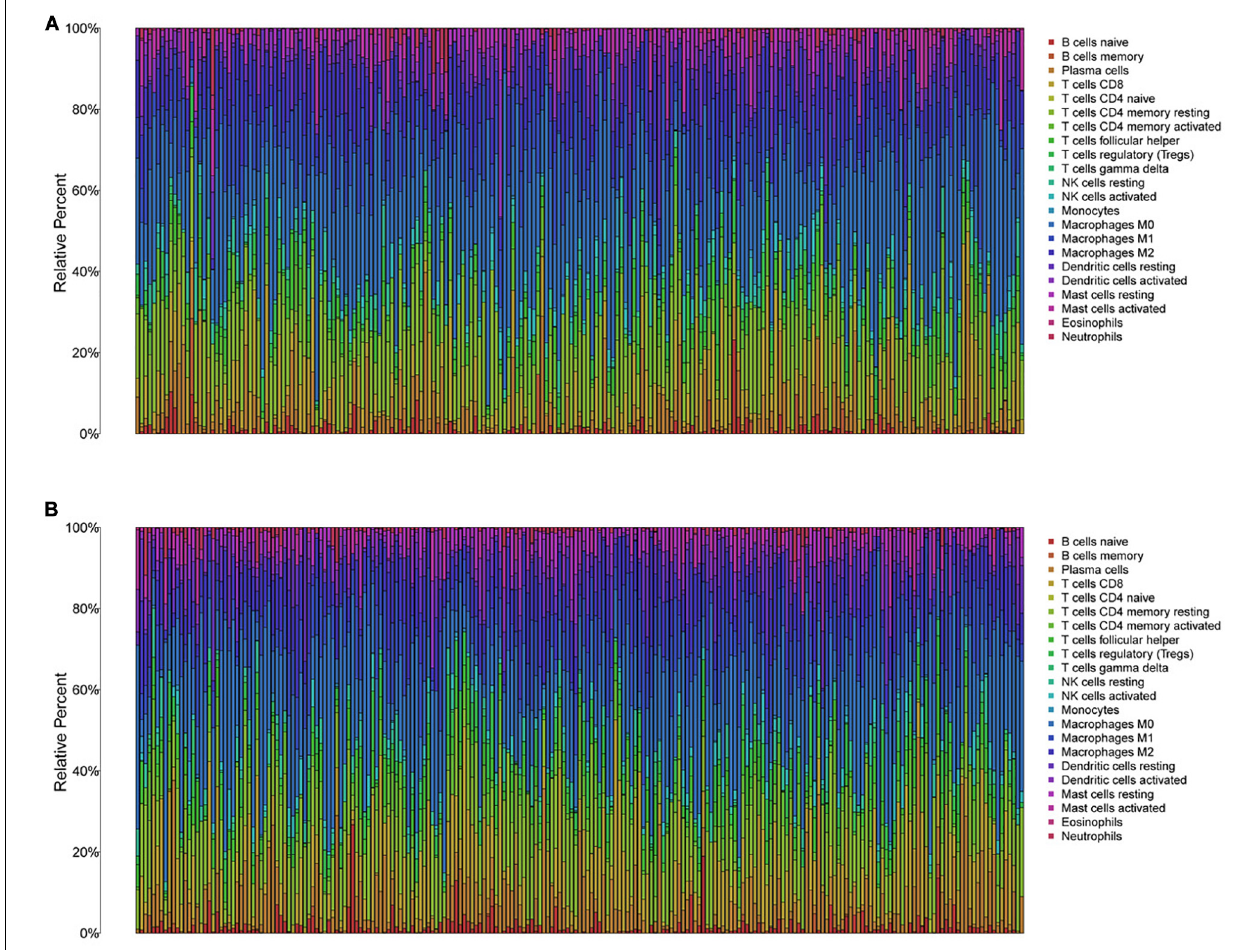
FIGURE 6 | The immune infiltration of 22 immune cell types in high- and low-risk HNSCC patients. (A) The immune infiltration of 22 immune cell types in high-risk HNSCC patients. (B) The immune infiltration of 22 immune cell types in low-risk HNSCC